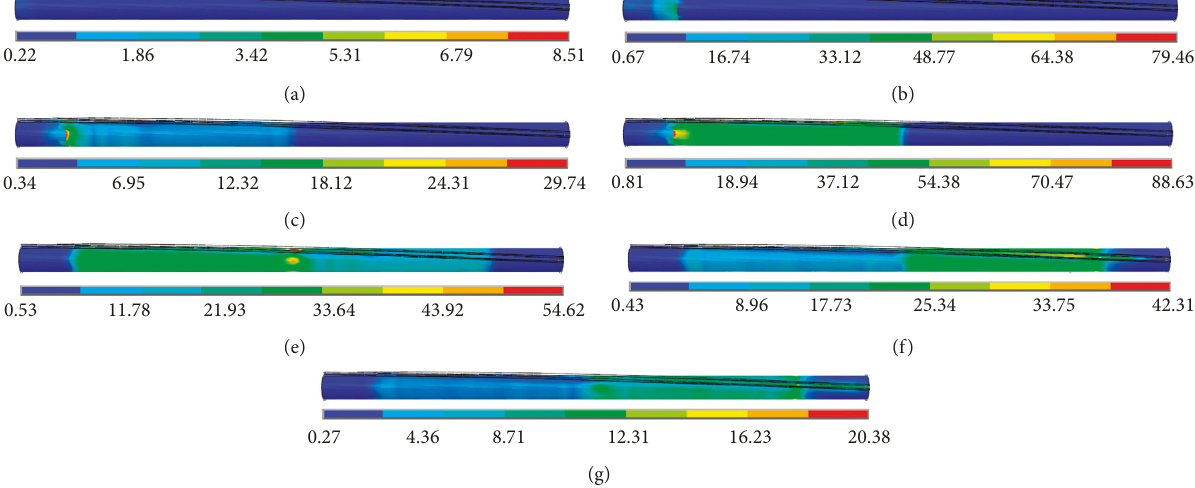
Figure 12: von Mises stress distribution of the inner surface under coupling state at different time periods. (a) 30ms. (b) 40ms. (c) 50 ms. (d) 60ms. (e) 70ms. (f) 80ms. (g) 90 ms.